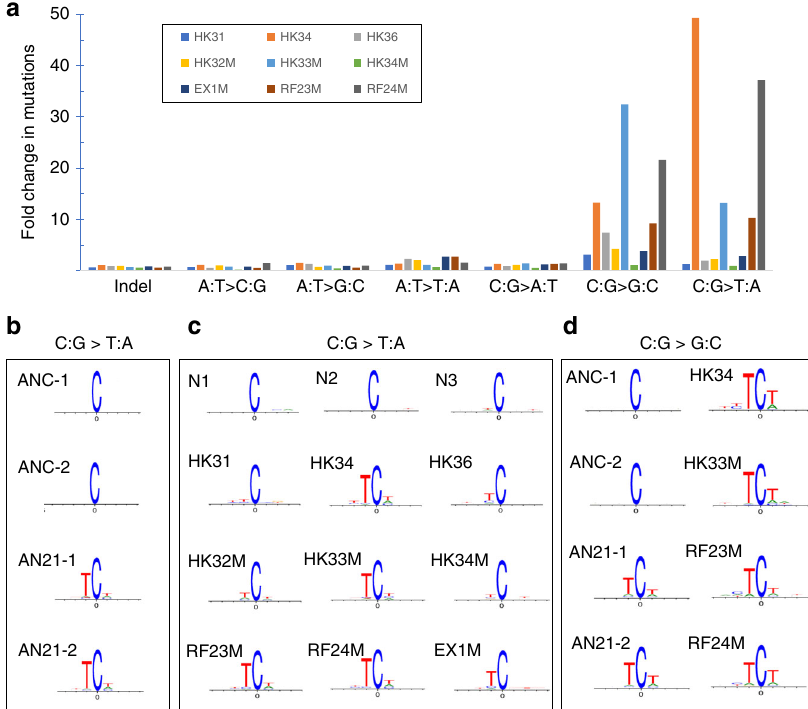
Fig. 3 Characterizations of the unintended mutations and identi fi cation of a sequence signature related to APOBEC activity. a Fold change of each type of mutation in base-edited iPSC clones as compared to control clones. A fold change is calculated by dividing the number of one type of mutation detected in one clone by the average number of that mutation type (indicated on x-axis) detected in three control clones N1, N2 and N3. Source data are provided in the Source Data fi le. b Sequence logos of the conserved bases around the C>T mutations in each iPSC clone after inducible base editor expression. The mutated C is shown at position 0. The overall height of each stack indicates the sequence conservation at that position, while the height of symbols within the stack indicates the relative frequency of each nucleic acid at that position 22 . Sequence logos from position − 5 to position 25 are shown in Supplementary Fig. 3. c Sequence logos of the conserved bases around the C>T mutations in iPSC clones edited by transient transfection. d Sequence logos of the conserved bases around the C->G mutations in iPSC clones that each has more than 40 detected C:G->G:C